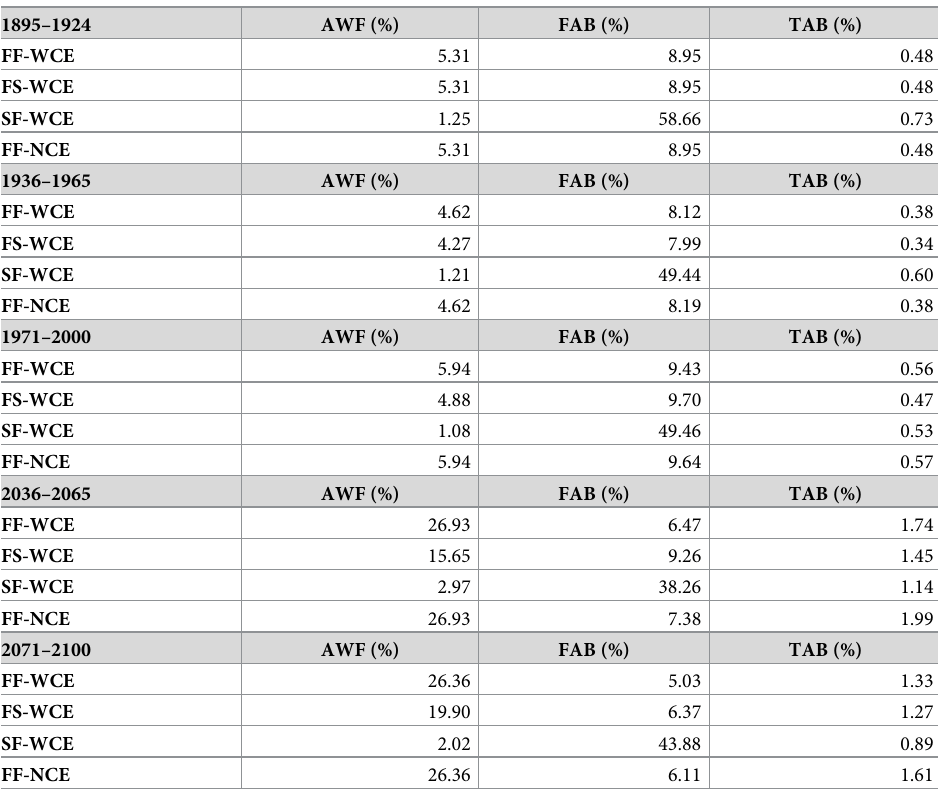
Table 5. Summaries of fire characteristics over the study area.